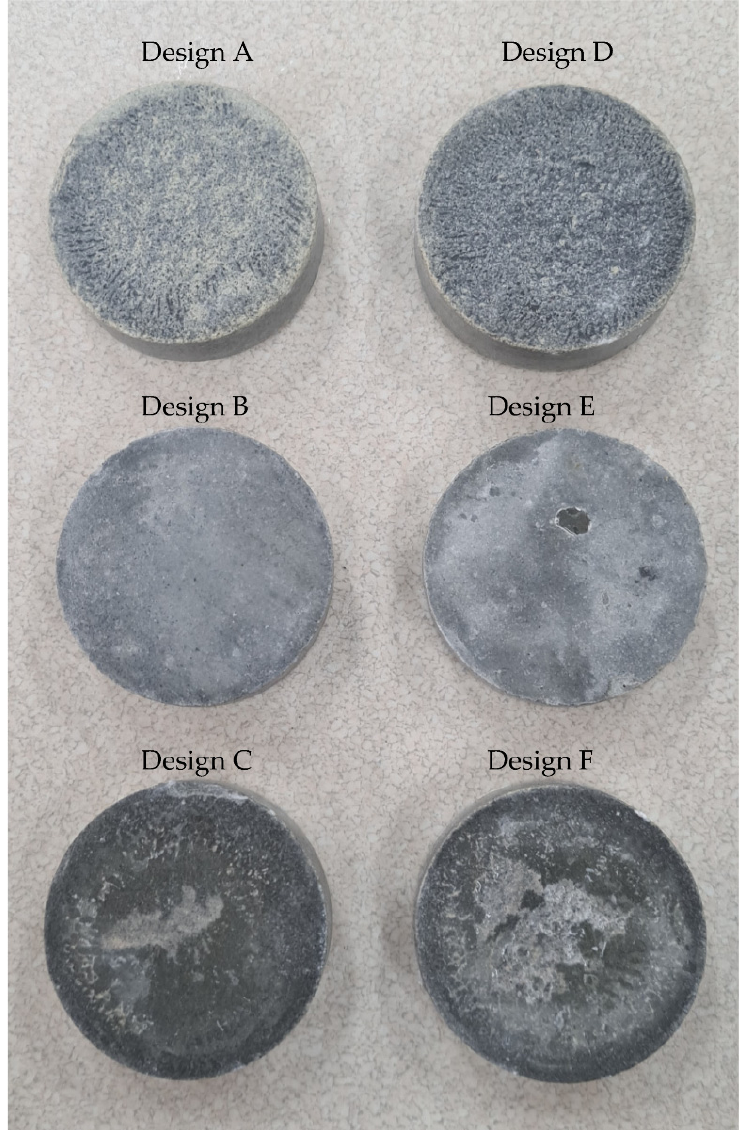
Figure 3. Sample prepared for thermal conductivity tests. Table 1. Composition of individual designs.